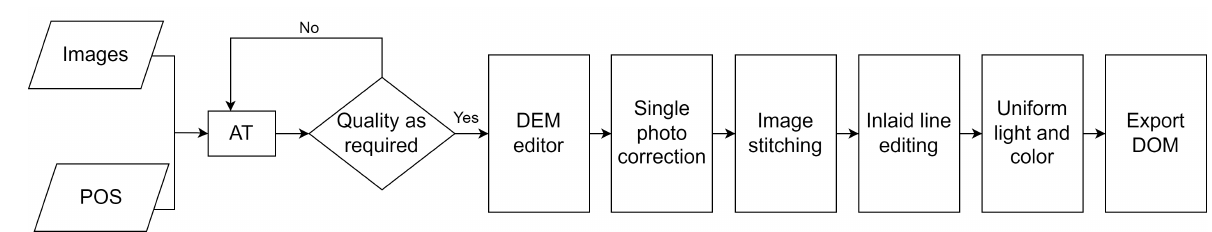
Figure 6. Route and images: ( a ) UAV route in update regions and ( b ) images acquired by UAV (DJI Terra [47]).